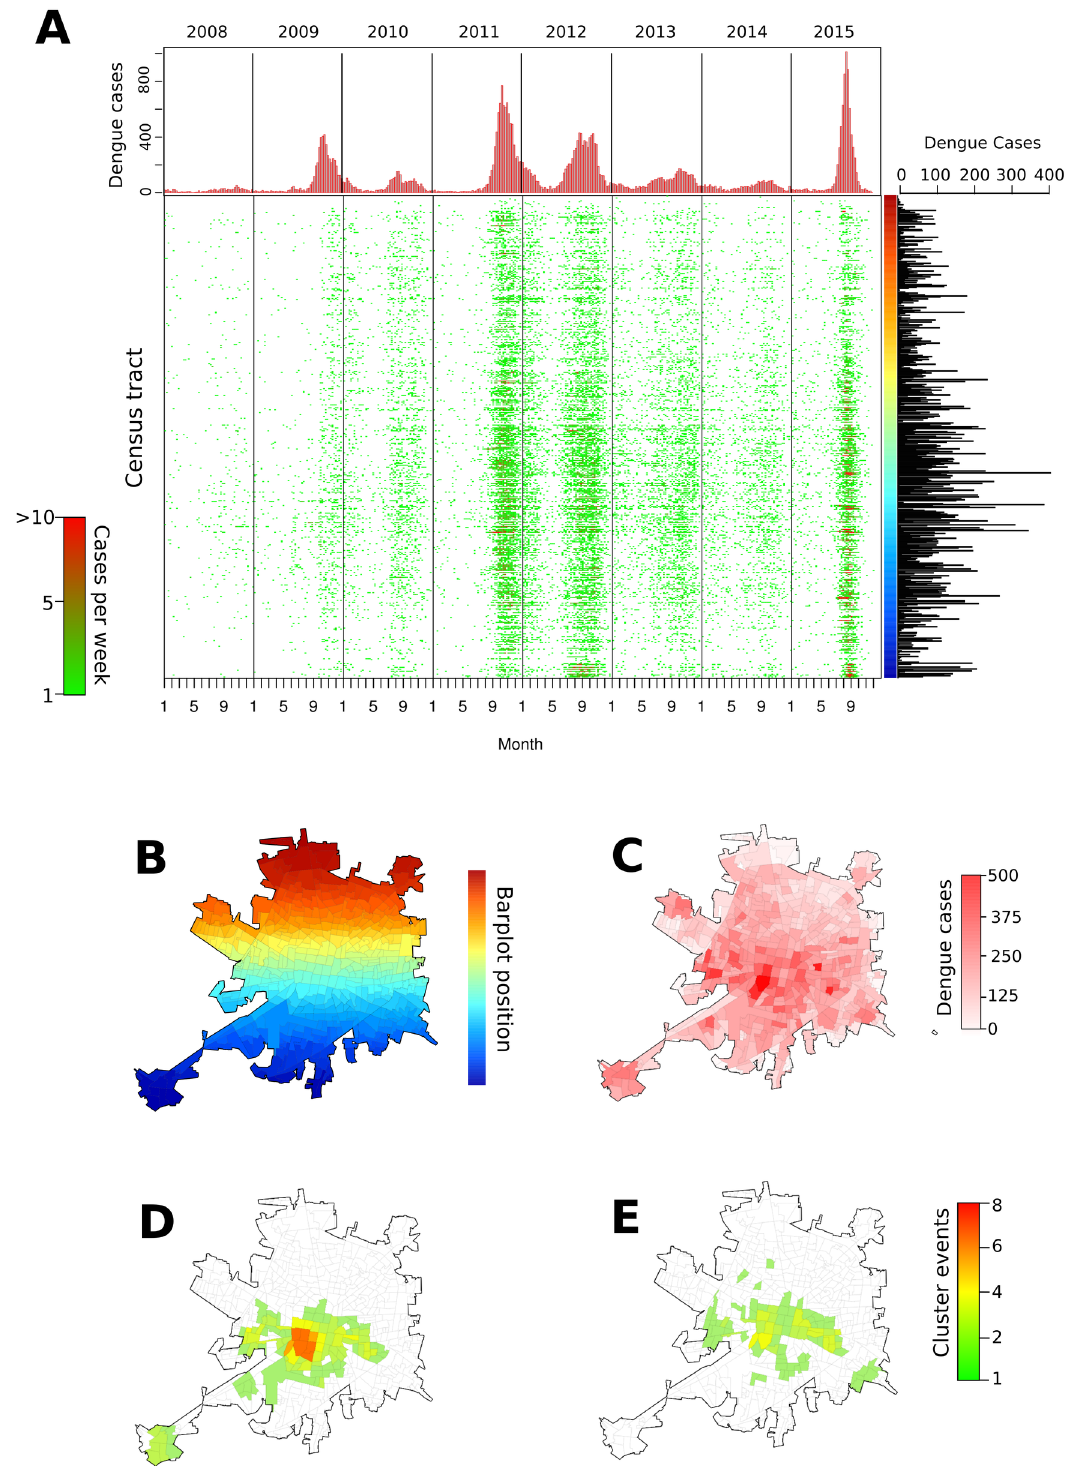
Fig 1. Spatio-temporal distribution of standardized dengue virus (DENV) cases in Merida, Mexico, during 2008–2015. (A) Weekly case counts are shown as bar plot (above) and by census tract (each row is a tract and rows are arranged by geographic proximity, with near units being next to each other, as shown in the color bar located on the right margin which matches the color map in (B)). Right panel shows total count of dengue cases per census unit during 2008–2015, which is mapped in (C). Panel (D)